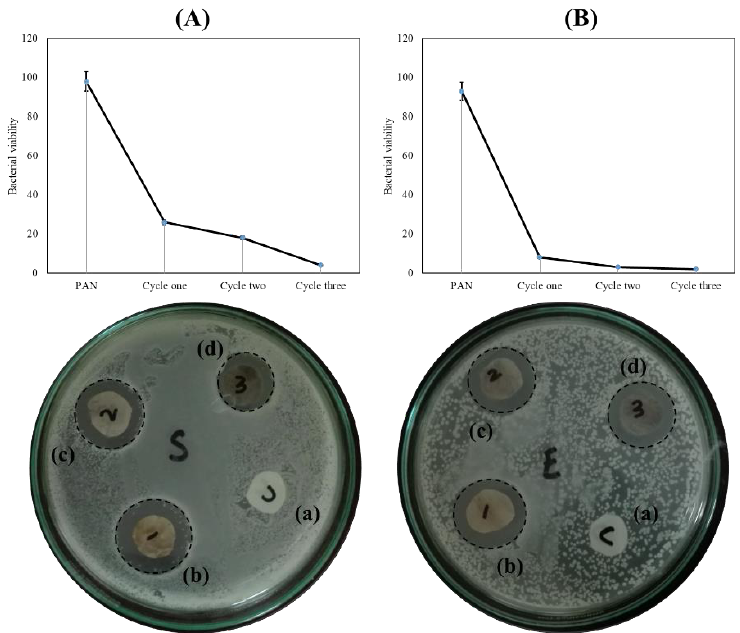
Figure 7. The antibacterial result of PAN/AgNPs nanofibers Staphylococcus: ( A ) and Escherichia-coli: ( B ). (Pure PAN nanofiber: (a), one cycle: (b), two cycles: (c), and three cycles: (d)).